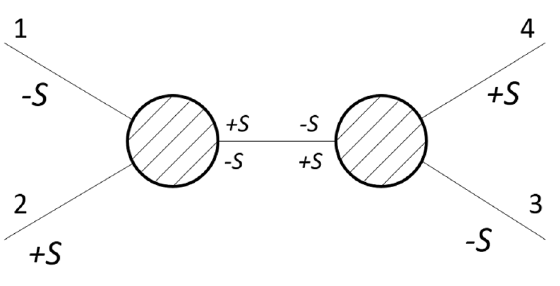
Figure 4. Two choices for the helicity configuration of the exchanged